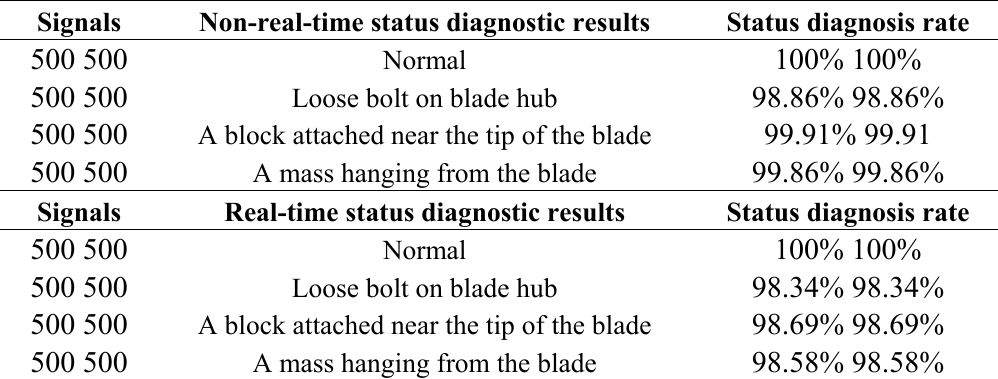
Table 2. Non-real-time and real-time diagnosis